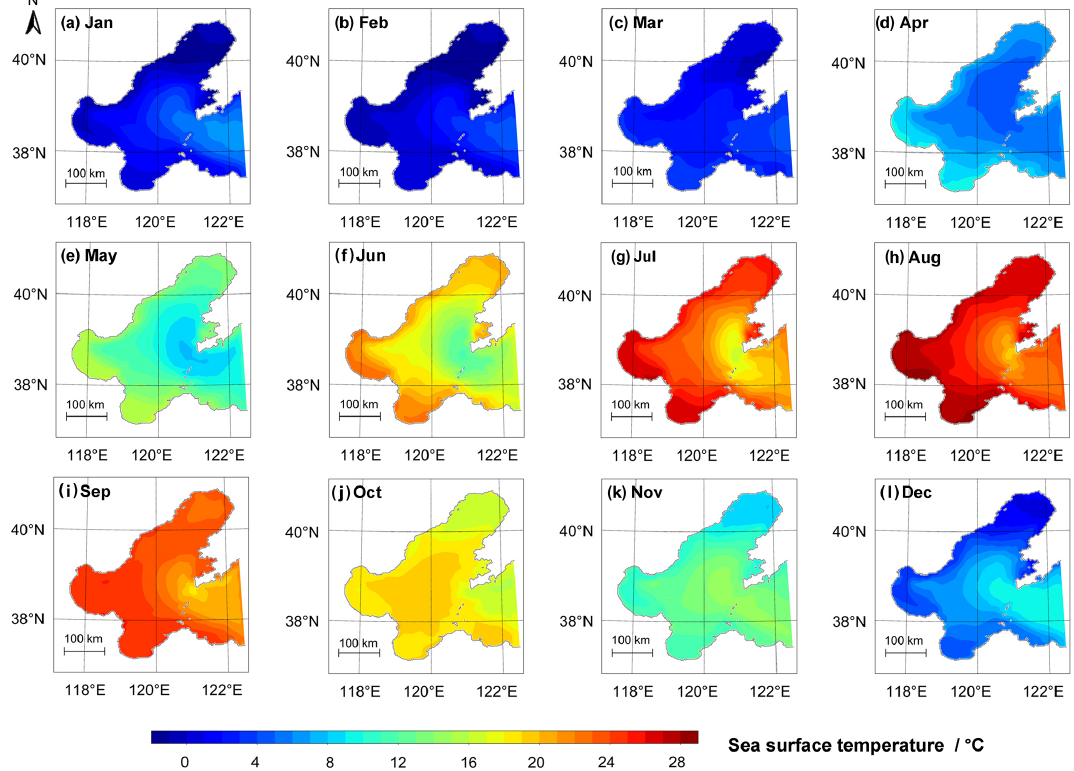
Figure 12. Spatial distributions of multi-year monthly average sea surface temperature in the Bohai Sea for the period of 1996–2017. Table 3. Comparison of multi-year average sea surface salinity between the observations and simulations. Station Longitude ( ◦ ) Latitude ( ◦ ) Observations (PSU) Simulations ∗ (PSU) Relative deviation Wentuozi 121.41 39.72 30.5 30.1 − 1 . 3% Huludao 120.81 40.56 119.92